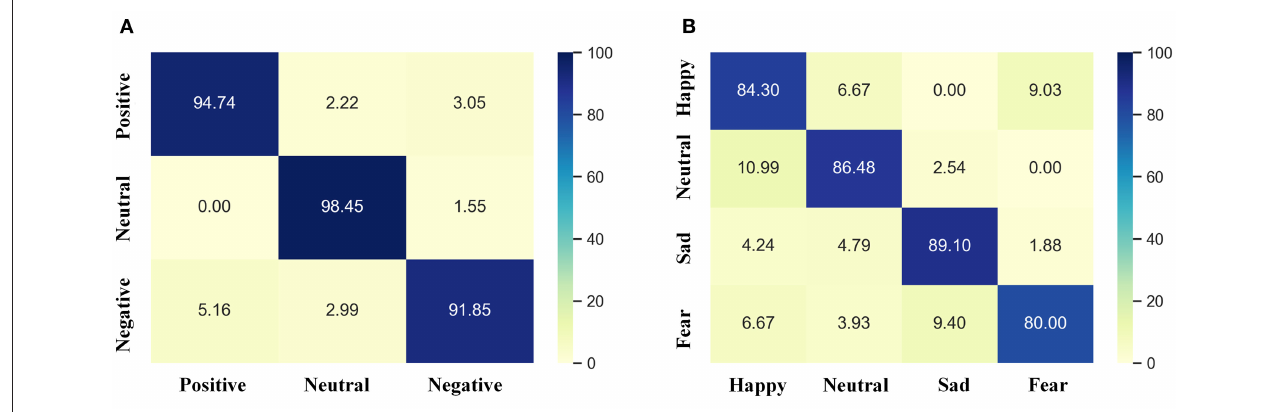
FIGURE 3 | Confusion matrix of different data sets. (A) is the confusion matrix of the SEED data set; (B) is the confusion matrix of the SEED-IV data set.